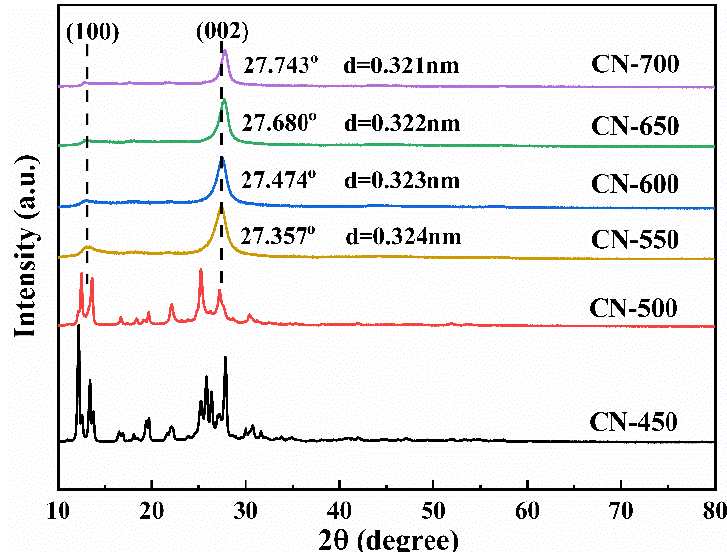
Figure 2. XRD patterns of samples.